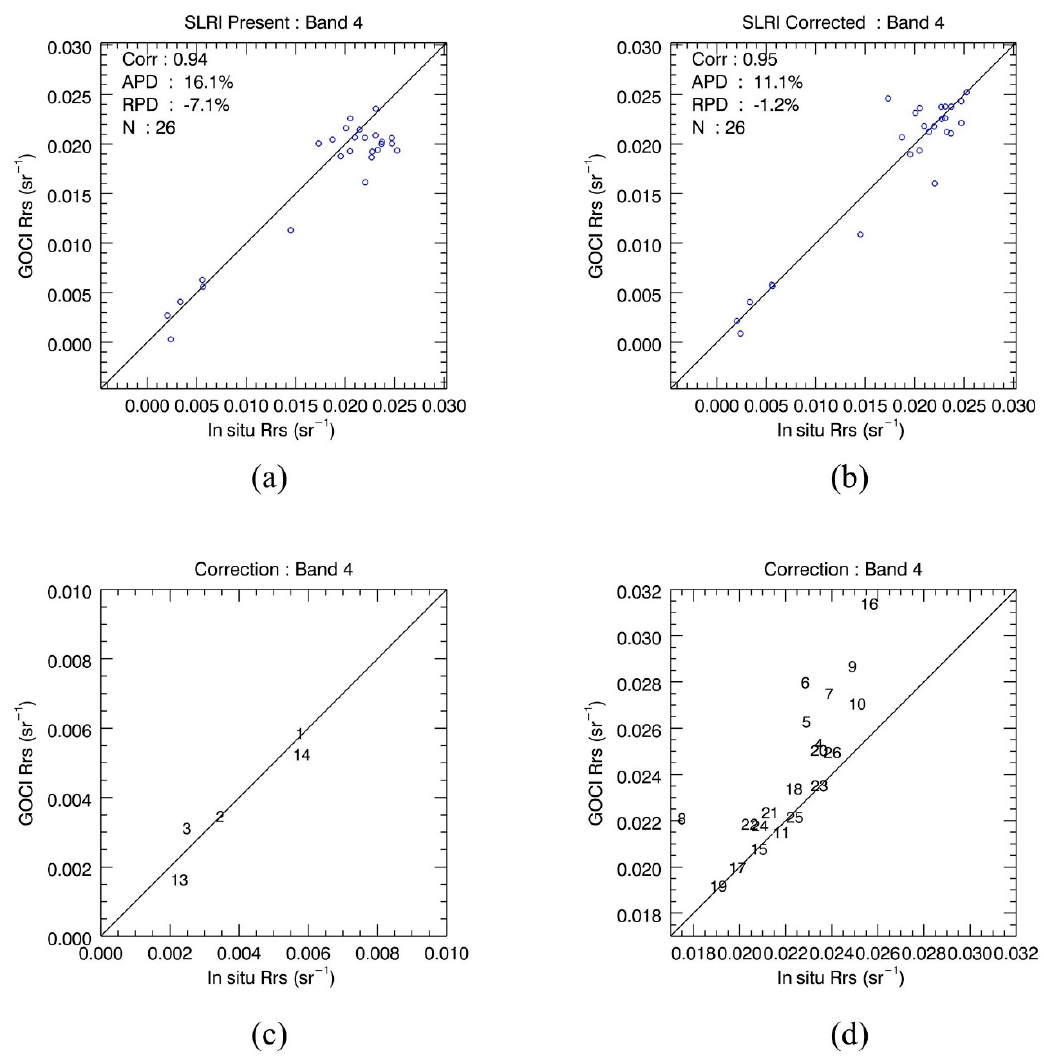
Figure 5. Scatter plots of remote sensing reflectance of Band 4 ( (cid:1844) (cid:3045)(cid:3046) (555)) between in situ and GOCI data: ( a ) before CIDUM and ( b ) after CIDUM. Changes in (cid:1844) (cid:3045)(cid:3046) ( i.e. , correction) are plotted on the data: ( a ) before CIDUM and ( b ) after CIDUM. Changes in R rs ( i.e. , correction) are plotted on the one-to-one line with station ID’s: ( c ) small (cid:1844) (cid:3045)(cid:3046) values and ( d ) large (cid:1844) (cid:3045)(cid:3046) values. one-to-one line with station ID’s: ( c ) small R rs values and ( d ) large R rs